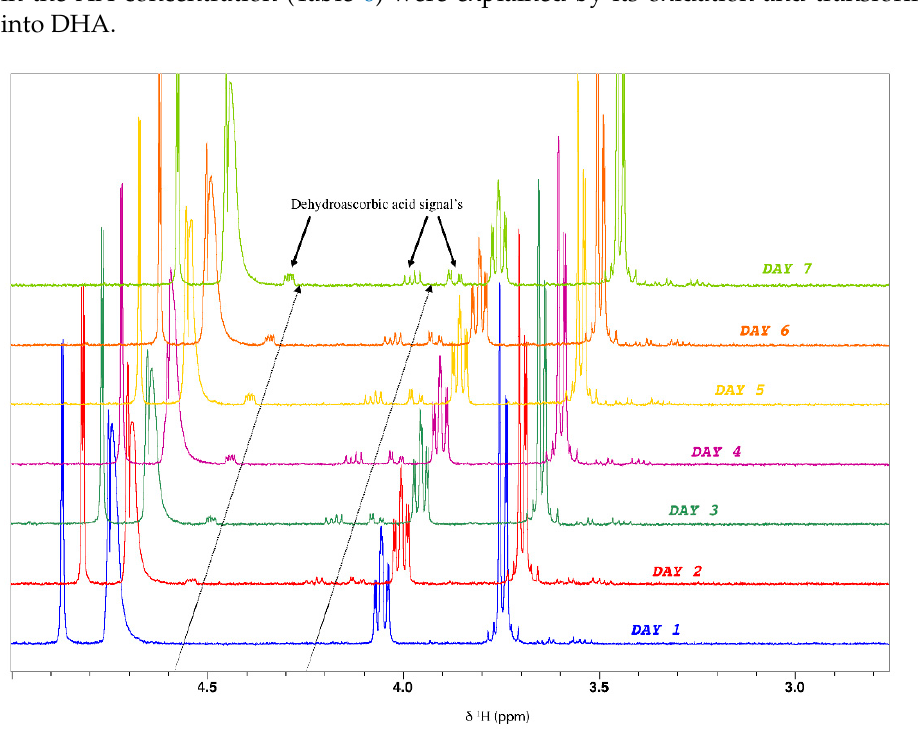
Figure 7. Evolution of the ascorbic acid spectrum as a function of time with the appearance of de ‐ hydroascorbic acid signals (400 MHz, 300 K, D 2 O, pH 3.35, 20 mM TSP). dehydroascorbic acid signals (400 MHz, 300 K, D 2 O, pH 3.35, 20 mM